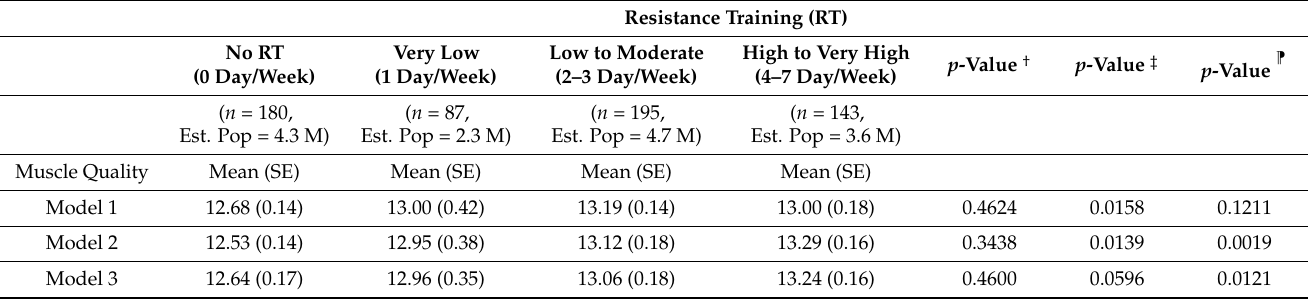
Table 6. Association between resistance training (0 day/week, 1 day/week, 2 day/week, 3 day/week,